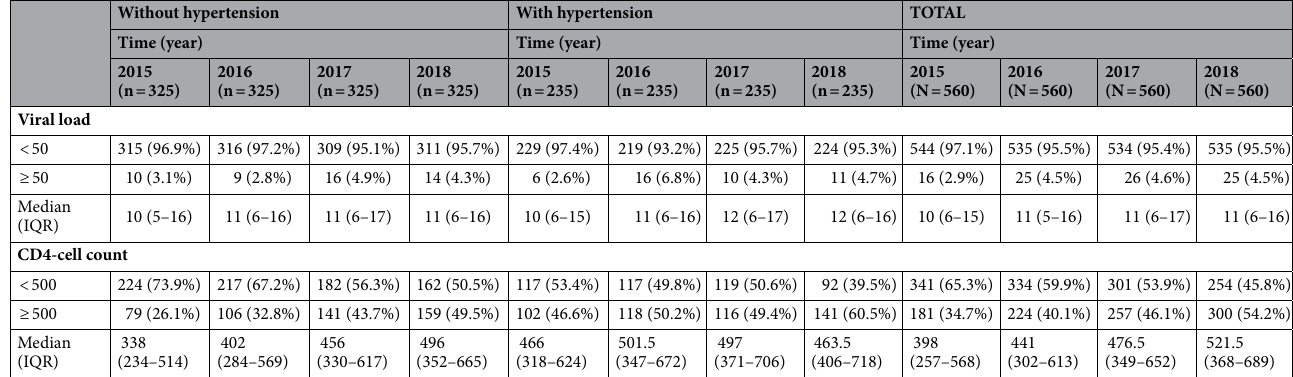
Table 3. HIV related outcomes. N: total study population; n: subset of study population; IQR: interquartile range; < : less than; ≥ : greater than or equals